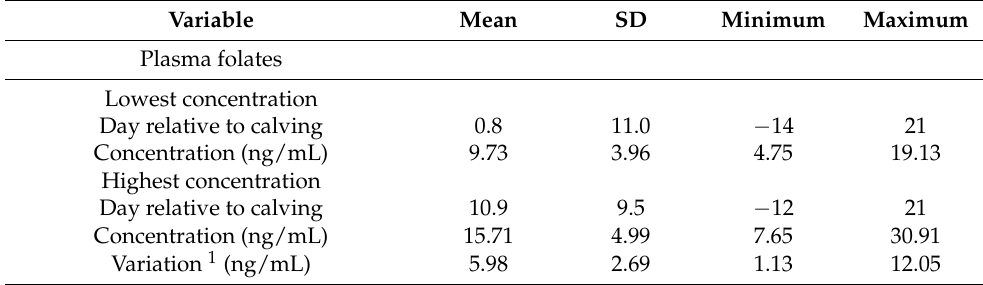
Table 2. Descriptive statistics of the lowest and the highest days of the event, and variation of plasma folate and vitamin B 12 concentrations observed in 48 multiparous Holstein dairy cows from days − 14 to 21 relative to